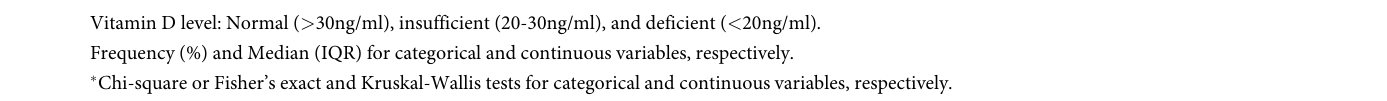
Table 3. Factors associated with a seroprotective antibody responses (GMT (cid:21) 40 vs. < 40).